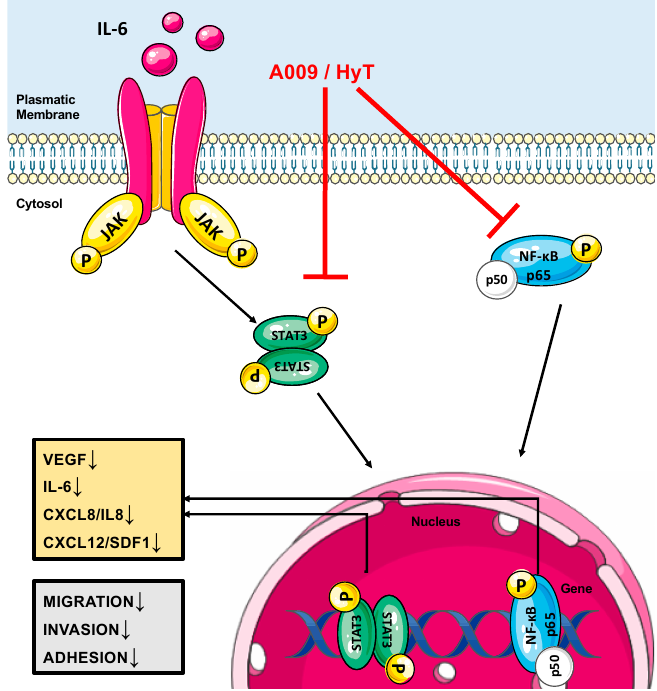
Figure 6. Schematic representation for the potential chemopreventive activities of A009 on prostate cancer cell lines in vitro. The cartoon summarizes the major findings at cellular and molecular levels associated with the targets of A009 identified in the manuscript, down arrow ( ↓ ) means downregulation of the protein or function.